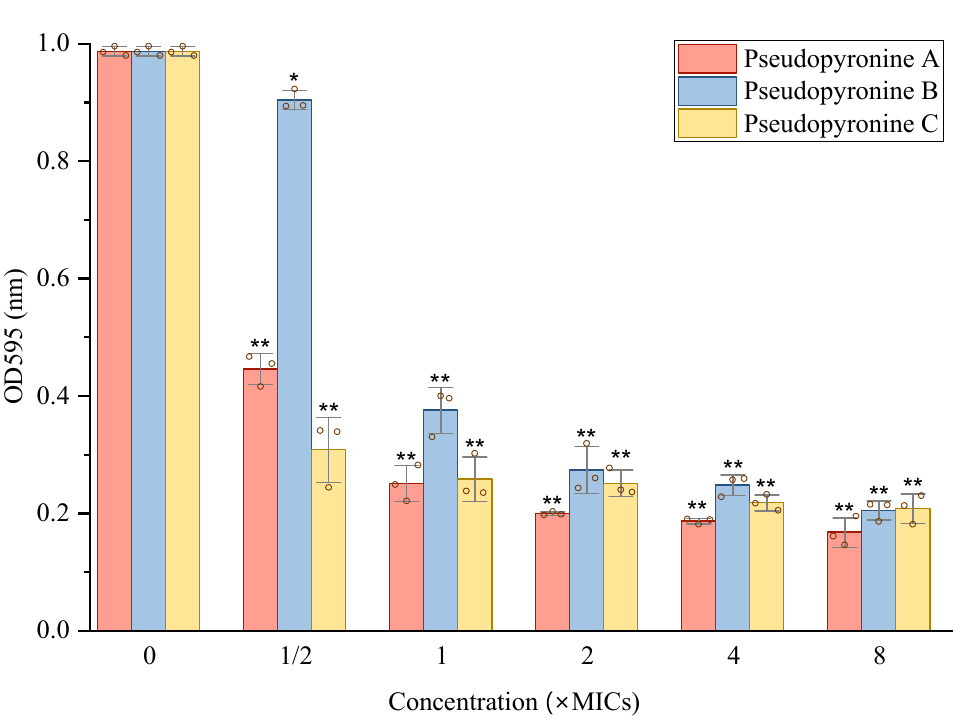
Figure 5. Reduction effects of sub-MIC concentrations of pseudopyronine A, B and C on metabolic activity of S. aureus evaluated by the MTT assay (1/2 × to 8 × MIC). Data are presented as mean ± SD, n = 3, * p < 0.05, ** p < 0.01, compared to the control group.